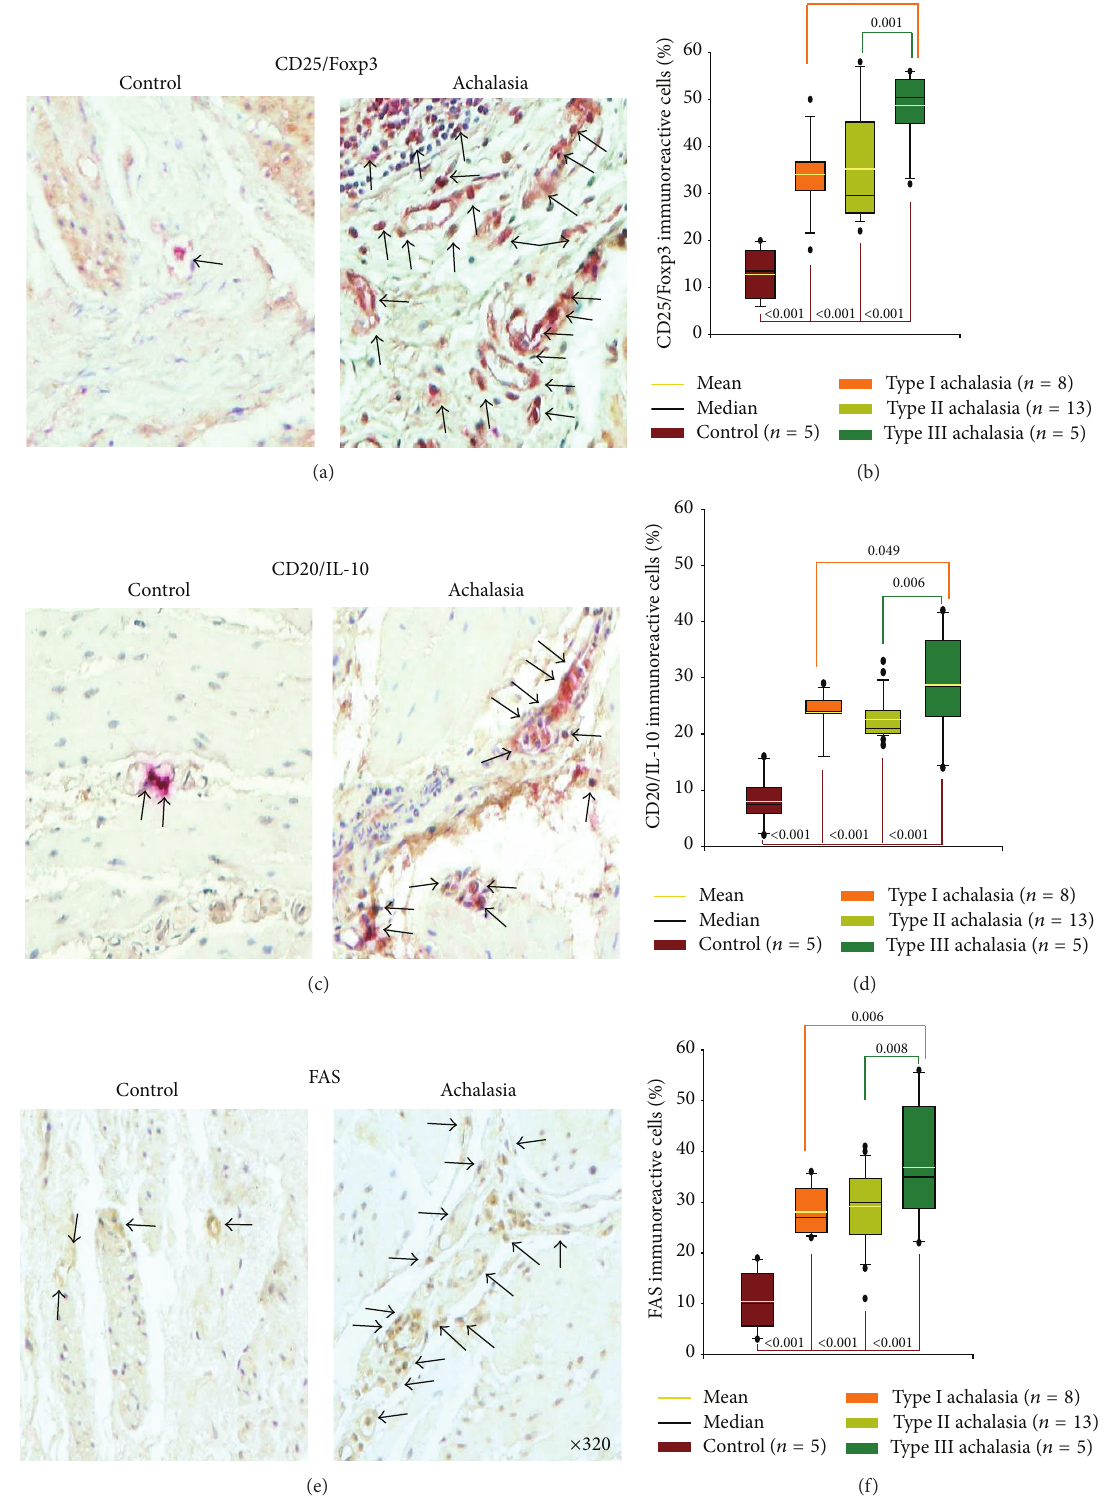
Figure 4: Regulatory cells and apoptosis in achalasia. Immunohistochemistry for (a) CD25/Foxp3 T cells, (c) CD20/IL-10 B cells, and (e) FAS cells in control and achalasia sections. Arrows depict immunoreactive cells. Original magnification was × 320. Results are expressed as mean (yellow line), median (black line), and 5th/95th percentiles of (b) CD25/Foxp3 + T cells, (d) CD20/IL-10 + B cells, and (f) FAS +